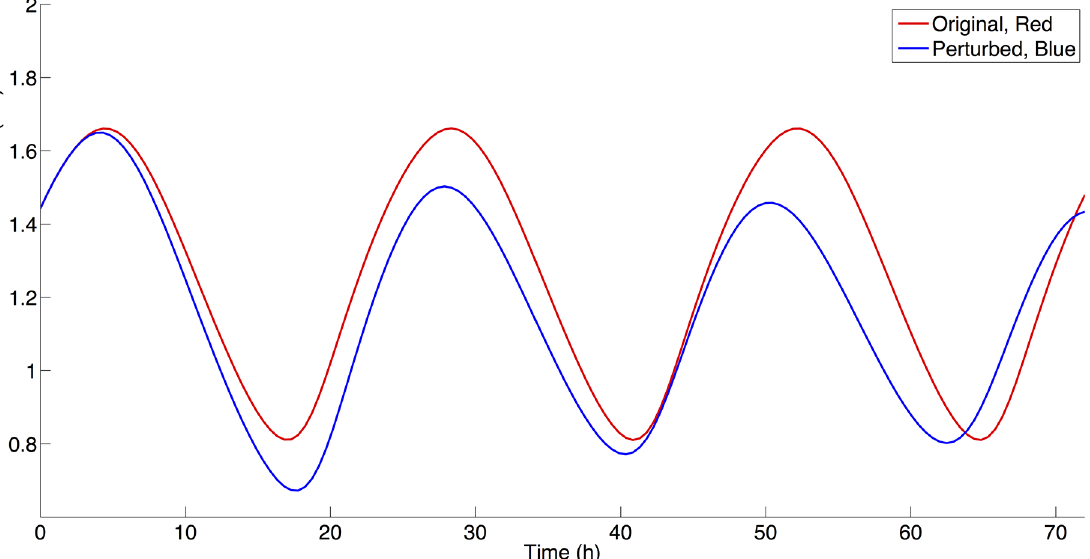
Fig 6. The effect of NAD biosynthesis decrease on CRY/PER mRNA levels. Red: Simulation using parameter values from Table 2. Blue: Simulation using parameter values from Table 2 with a 75% decrease in VNADc value.